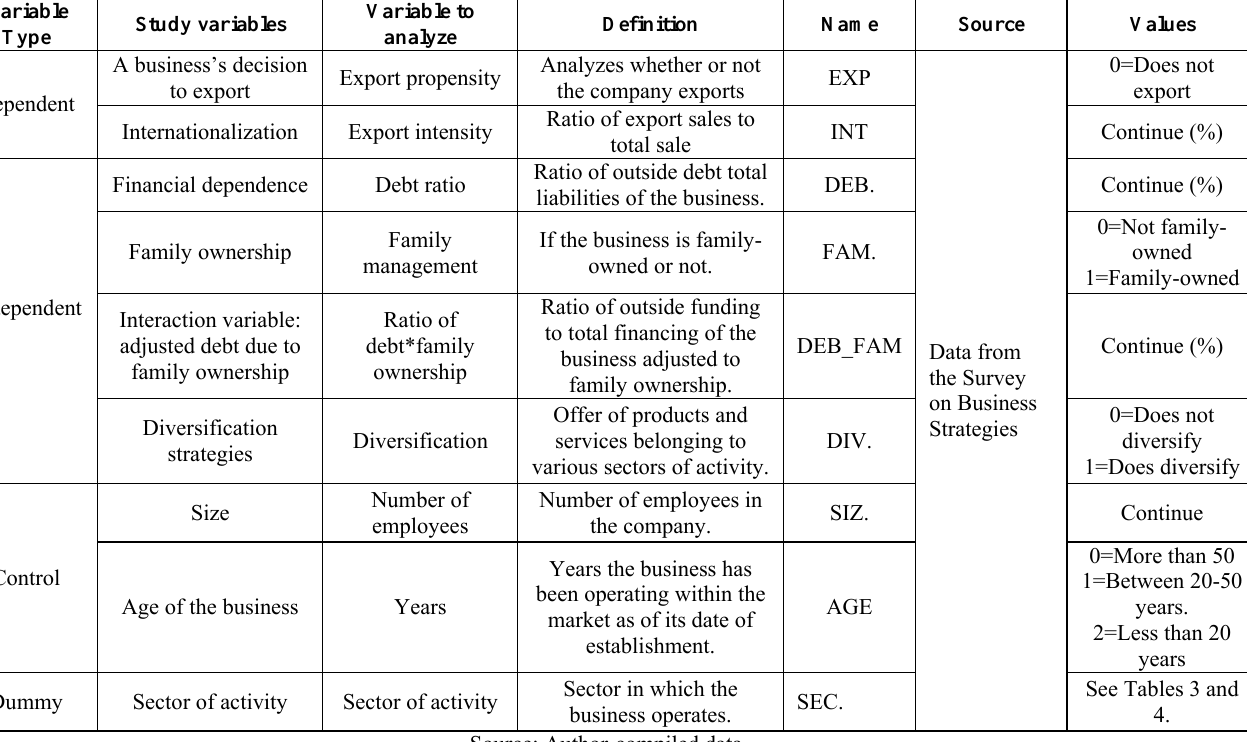
Table 2: Variables of proposed models